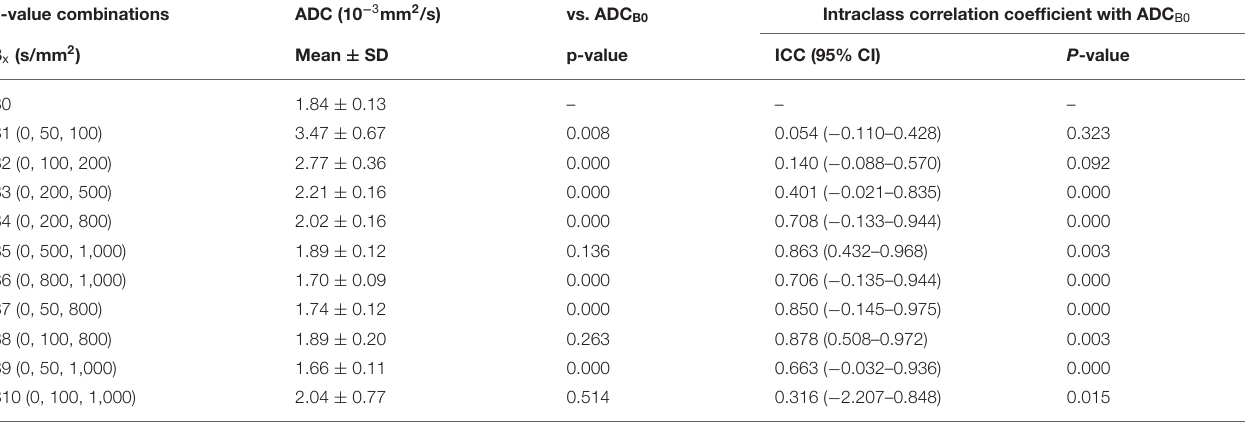
TABLE 4 | ADC values of the renal parenchyma according to the combination of b-values. b-value